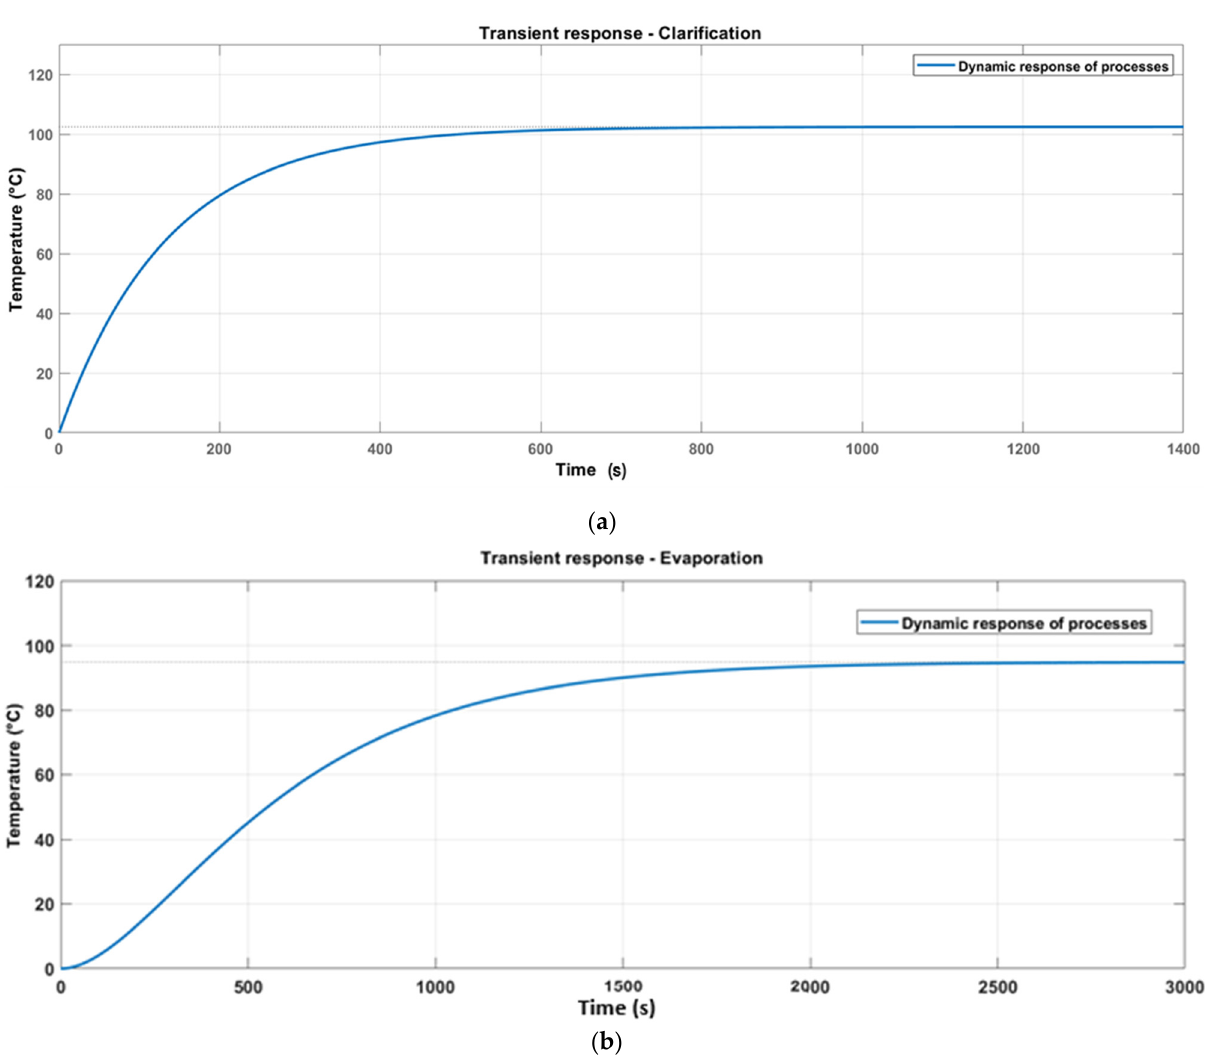
Figure 5. Transient response of each stage to the disturbances studied: ( a ) clarification; ( b ) evaporation.